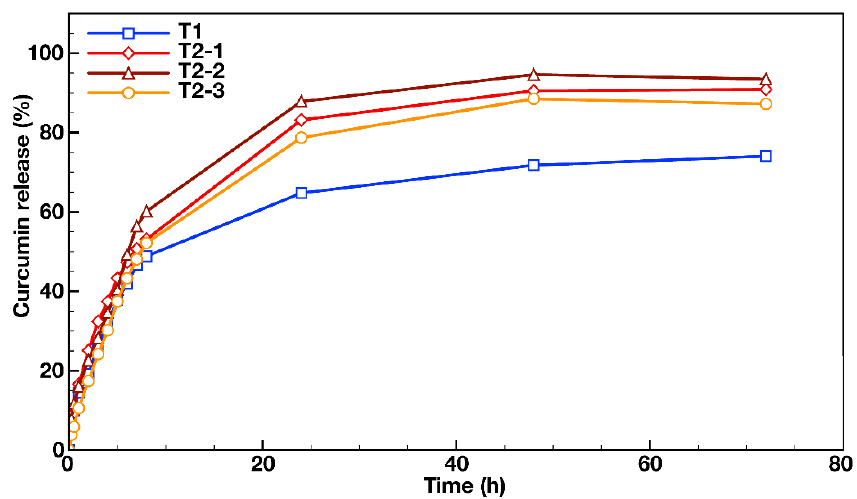
Figure 6. In vitro release profiles of curcumin from the different triblock copolymer micelles in a biphasic (water/chloroform) system at 37 °C.